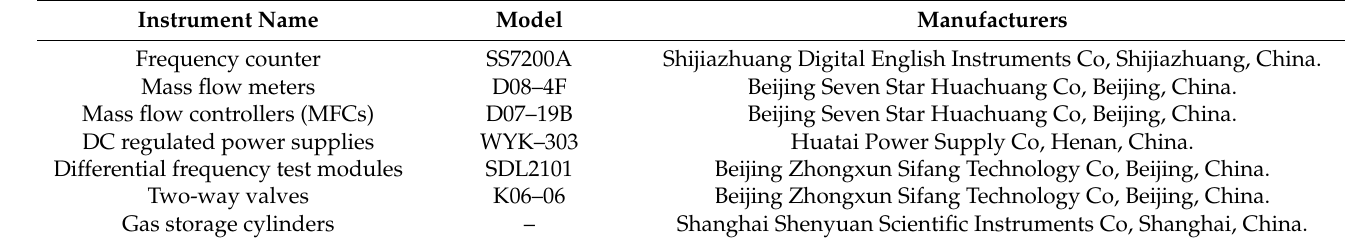
Table 2. Information sheet on the instruments used in the SAW sensor gas sensing test system.